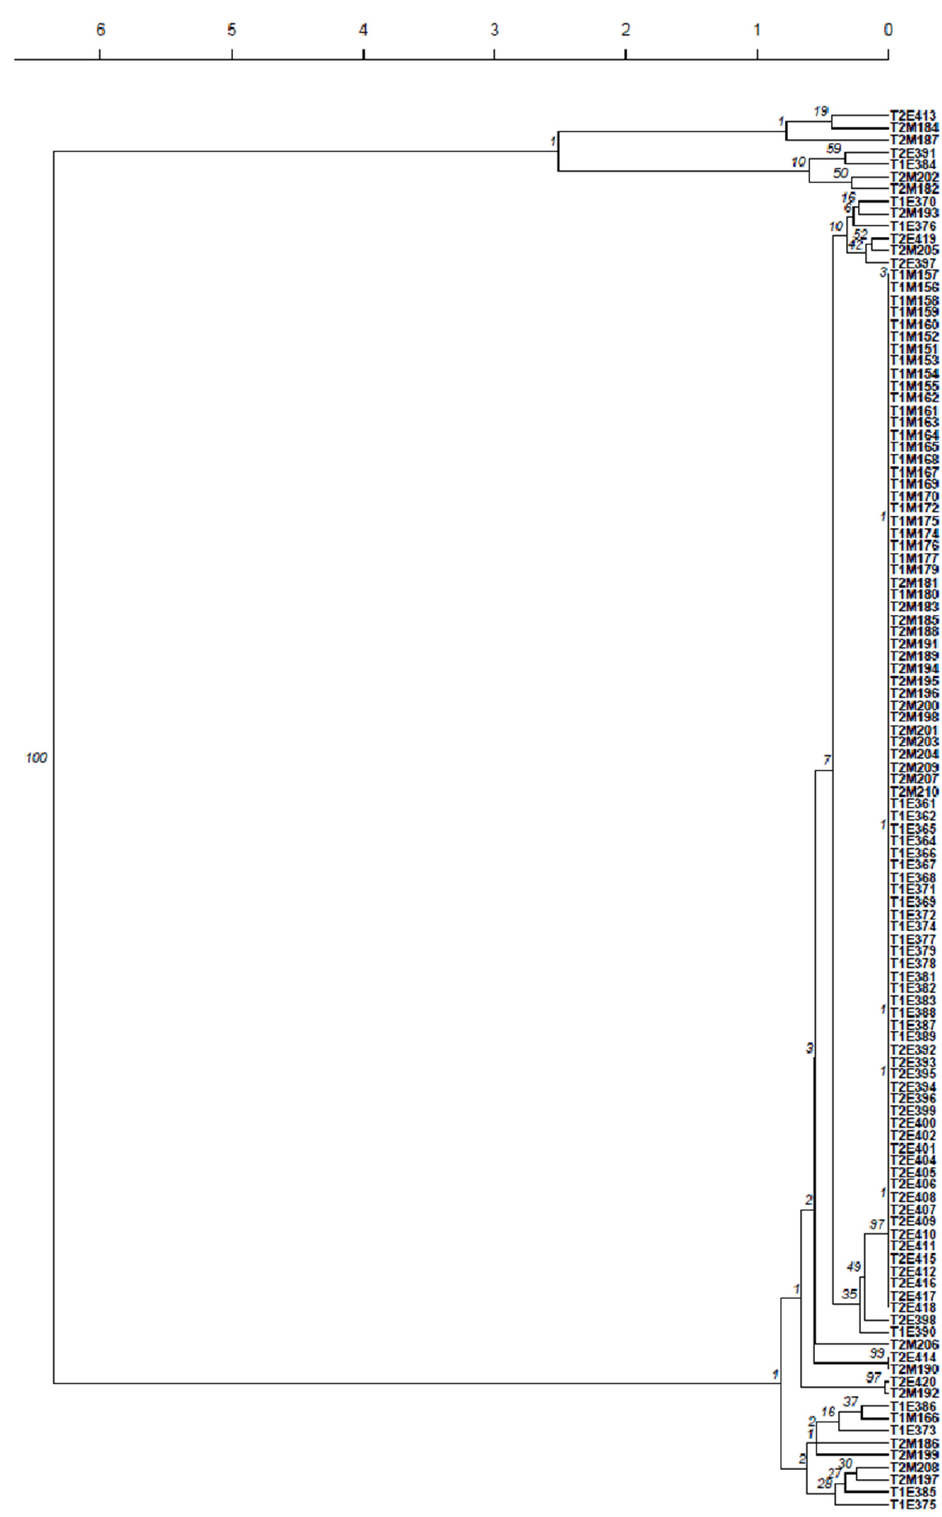
Figure 7. Dendrogram presenting the genetic distance between the isolates from the tannin prepara- tion modality based on the microsatellite profiles. Isolates from fermentation are represented by T1 or T2, depending on the tannin preparation used, followed by the letter M—middle or E—end of fermentation, and finally the number of the isolate. Scale at top represents genetic distance.